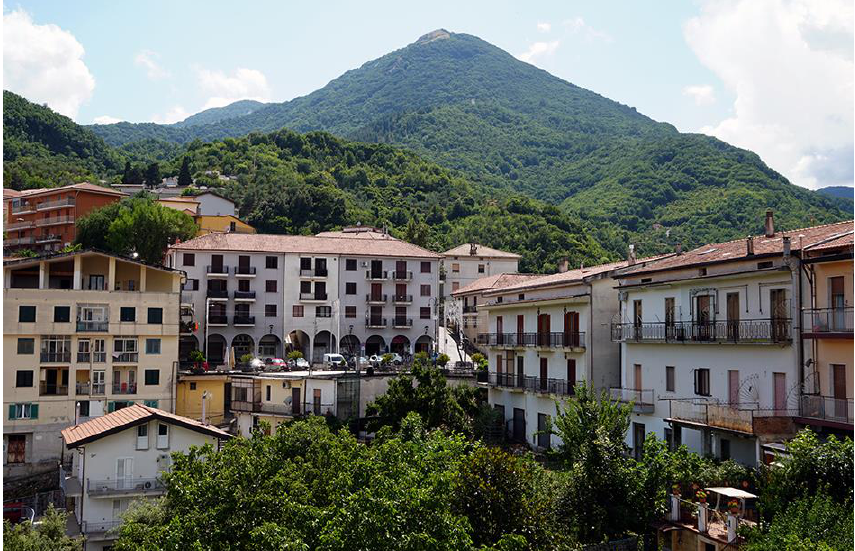
Figure 48. Calabritto: panoramic view of the village completely rebuilt (photos by [35,36]).